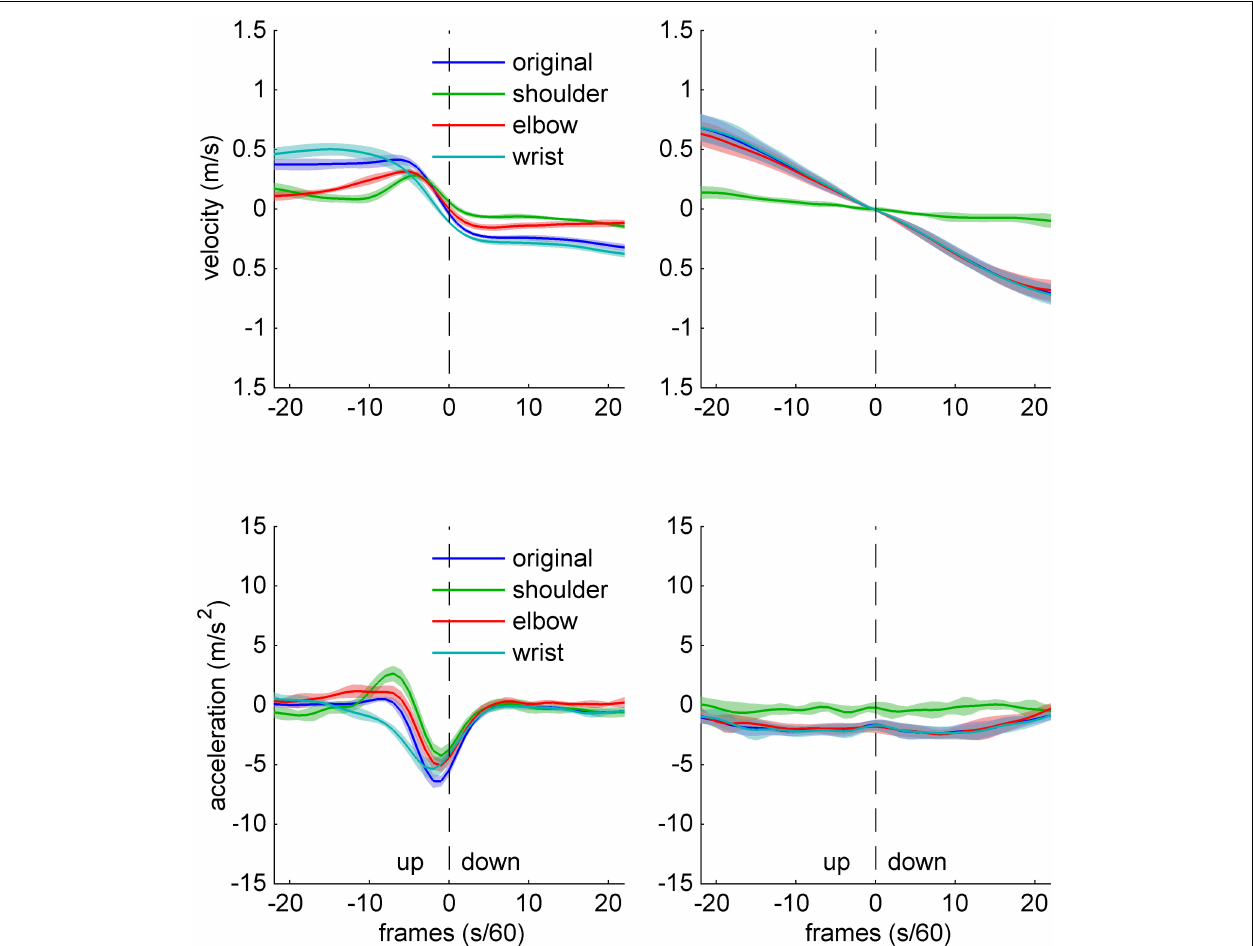
FIGURE 2 | Sample data of bow kinematics (velocity and acceleration) and joint angle movement for an Expert (left) and a Novice (right) cello player, during an up–down bow reversal. The different traces indicate